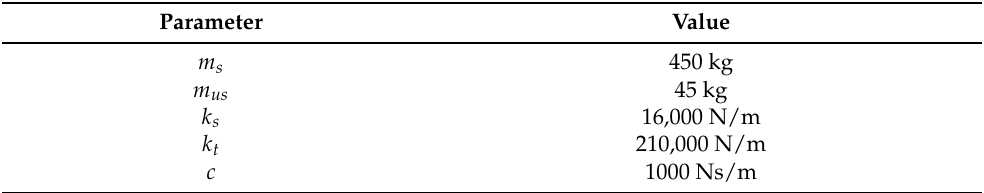
Table 2. One-quarter semi-active vehicle suspension